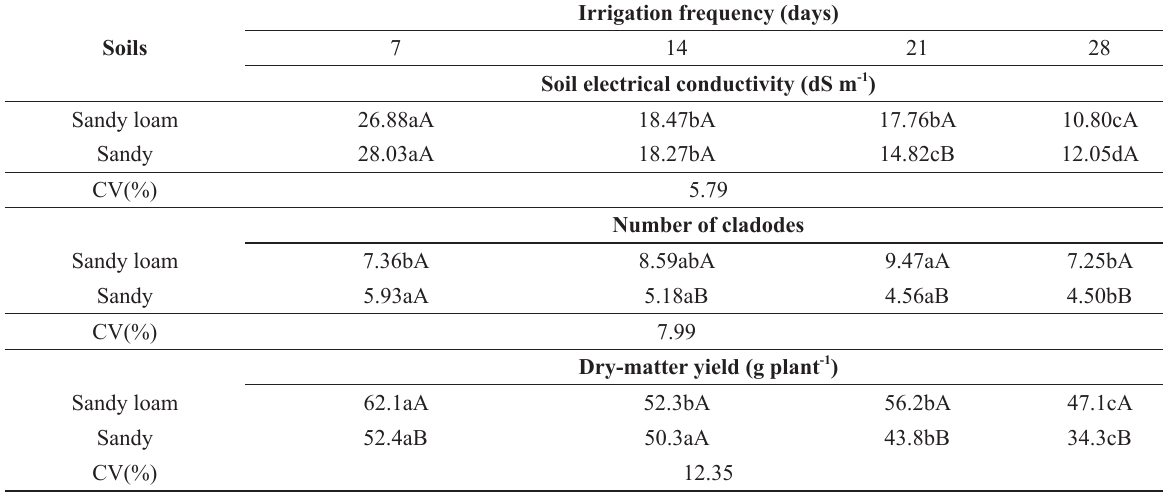
Soil electrical conductivity (dS m -1 ), number of cladodes and dry-matter yield (g plant -1 ) of cactus pear cv. Miúda according to the irrigation frequency and soil types.